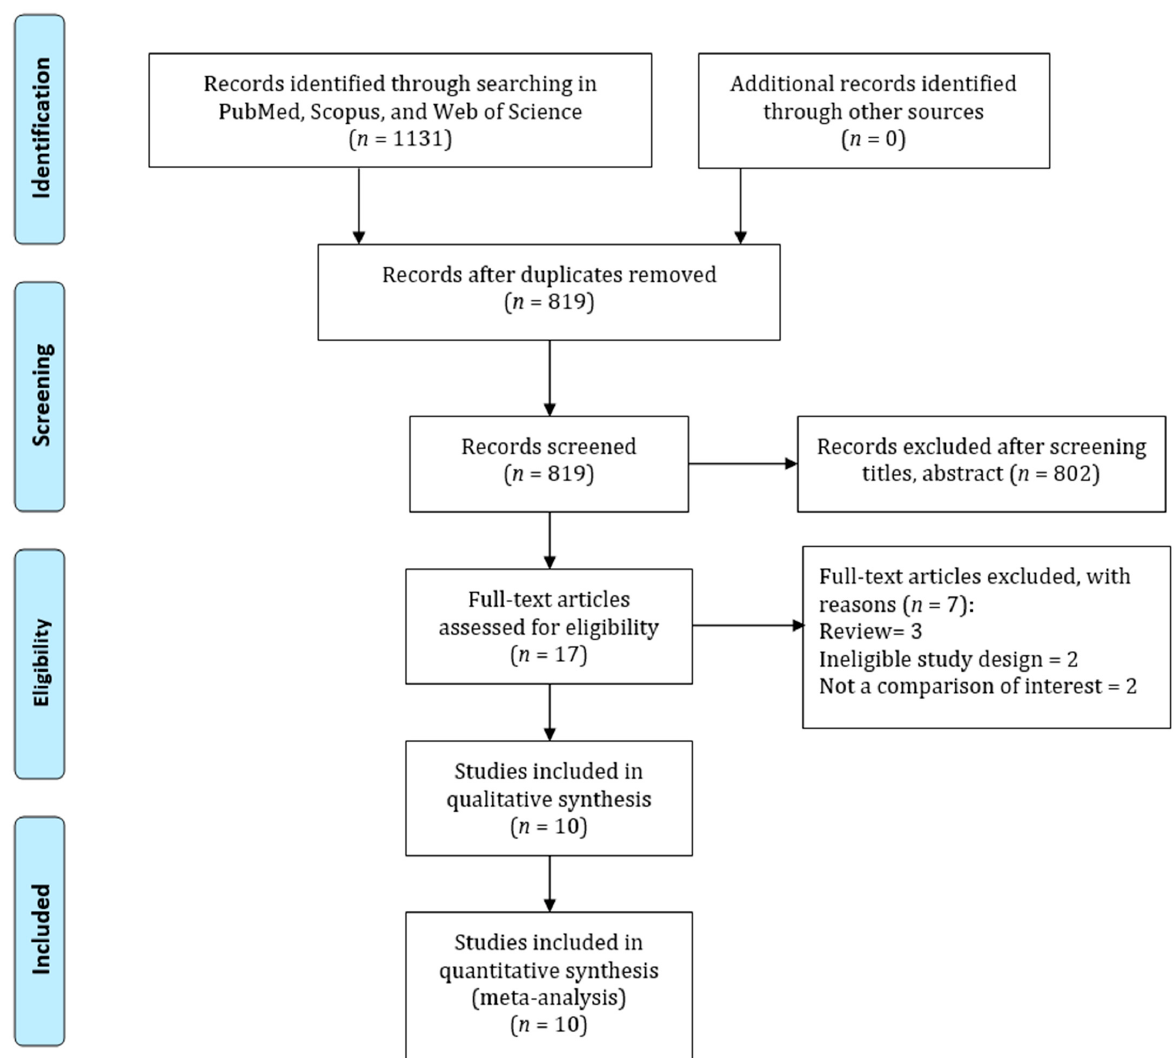
Figure 1. PRISMA guidelines for searching strategy of the association between PPI and CKD risk.